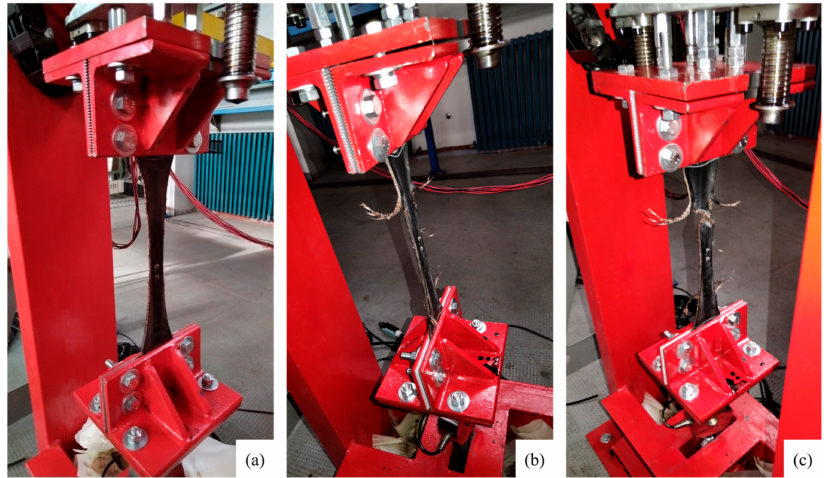
Figure 7. Phases of specimen testing: ( a ) initial phase, i.e., undamaged specimen; ( b ) during testing, visible damage; ( c ) the final stage, i.e., specimen